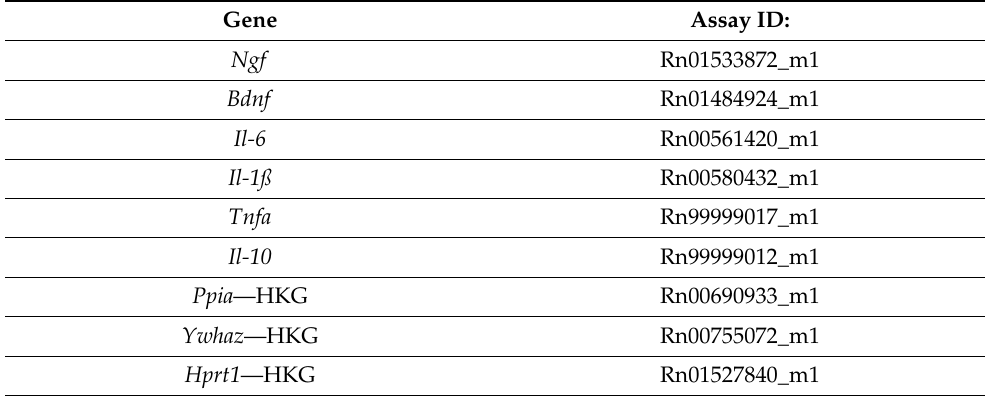
Table 2. TaqMan expression assays used for RT-PCR experiments, including house-keeping genes (HKG) used for the results